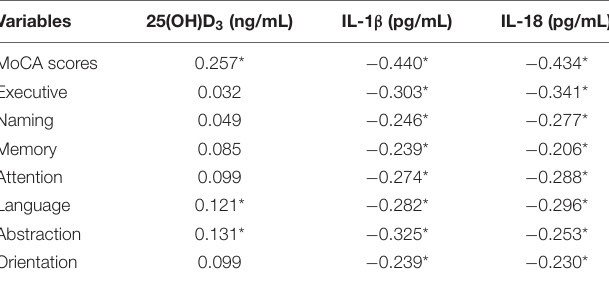
TABLE 2 | Spearman’s correlation of the association among cognitive function, 25(OH)D 3 , and inflammatory